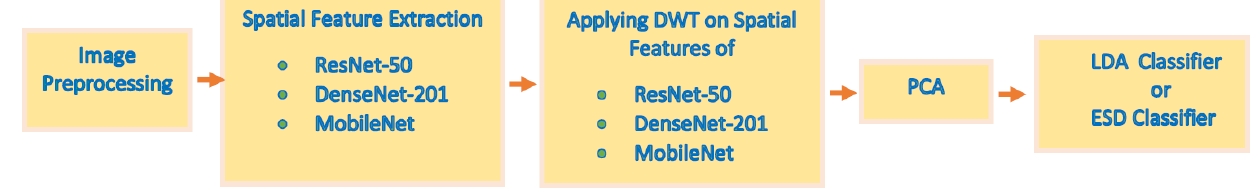
Figure 12. The final architecture of MB-AI-His.